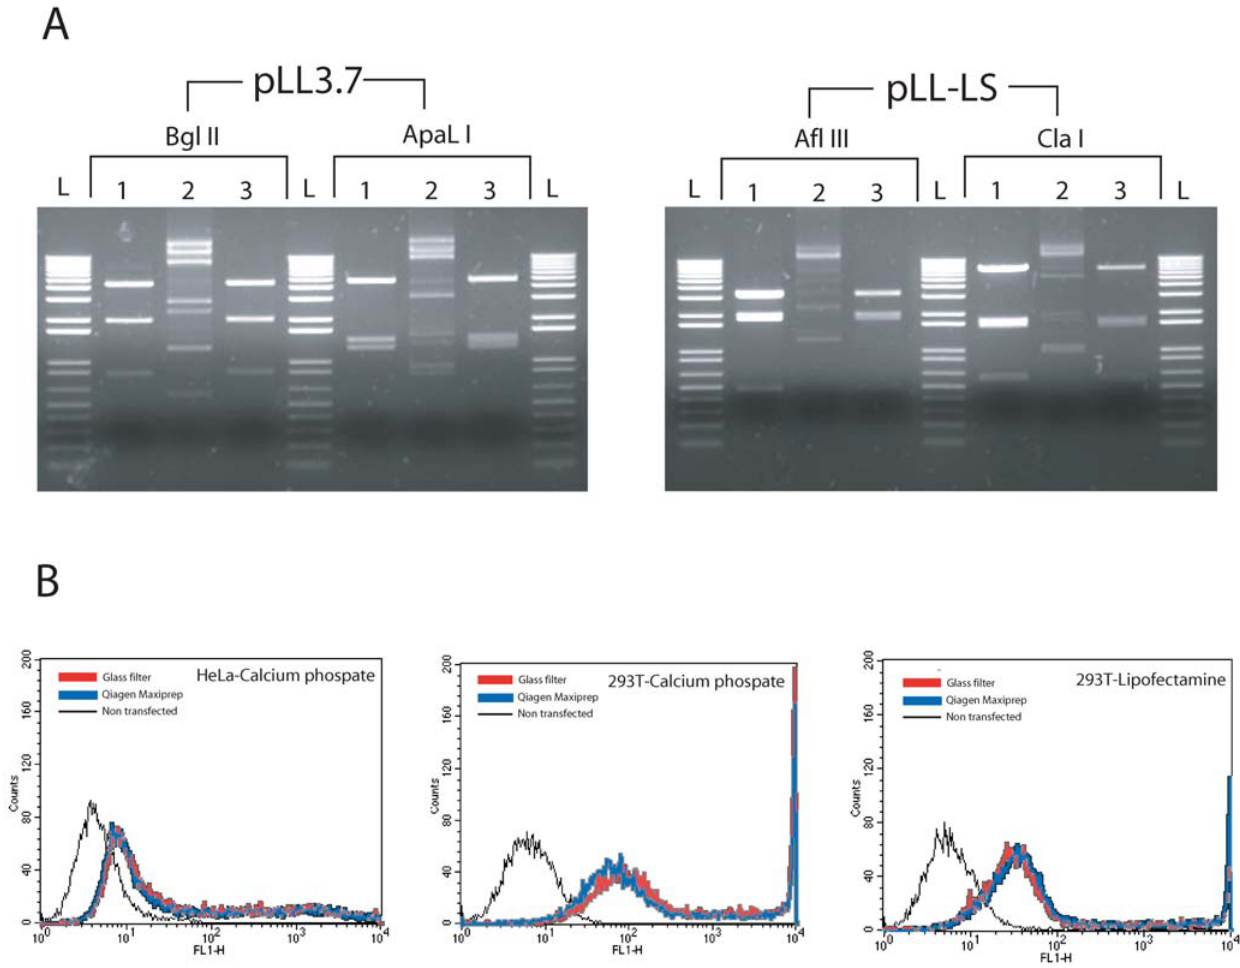
Figure 3. Test of plasmid quality using restriction enzyme digestion, ligation and transfection. (A) Plasmids purified by glass syringe filters were digested with the indicated restriction enzymes, the digested plasmid was ligated and then re-cut with the same restriction enzyme. 1: Initial restriction enzyme digestion. 2: Ligation at 16 u C for 12 hours. 3: Re-digestion with same enzyme. L: 1 kb ladder (Invitrogen) (B) GFP expression following transfection with purified pEGFP-N1. E.coli bearing pEGFP-N were cultured in 200 ml LB and plasmid purified using either a Qiagen Maxi- prep kit or glass syringe filters. The plasmid was quantitated by spectrophotometer and transfected into 293T and HeLa cells using lipofectamine or calcium phosphate. After 2 days, the transfected cells were harvested and GFP expression was analyzed by